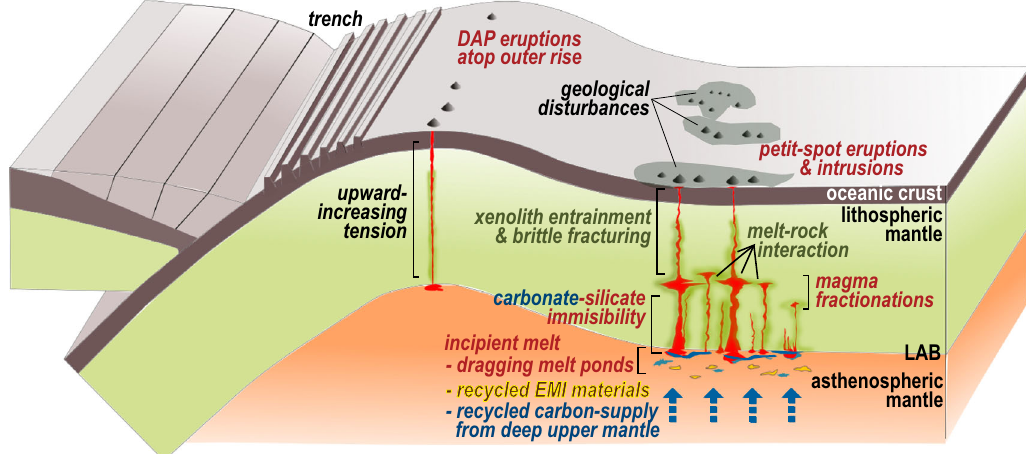
Fig. 8 Schematic model of the formation and melt ascent processes of petit-spot and DAP volcanoes. The majority of petit-spot melt at least plausibly ascend as carbonatitic melt after carbonatite/silicate immiscibility. The melts excluding DAPs stack in the middle or lower asthenosphere. The sources are originated from asthenosphere with recycled